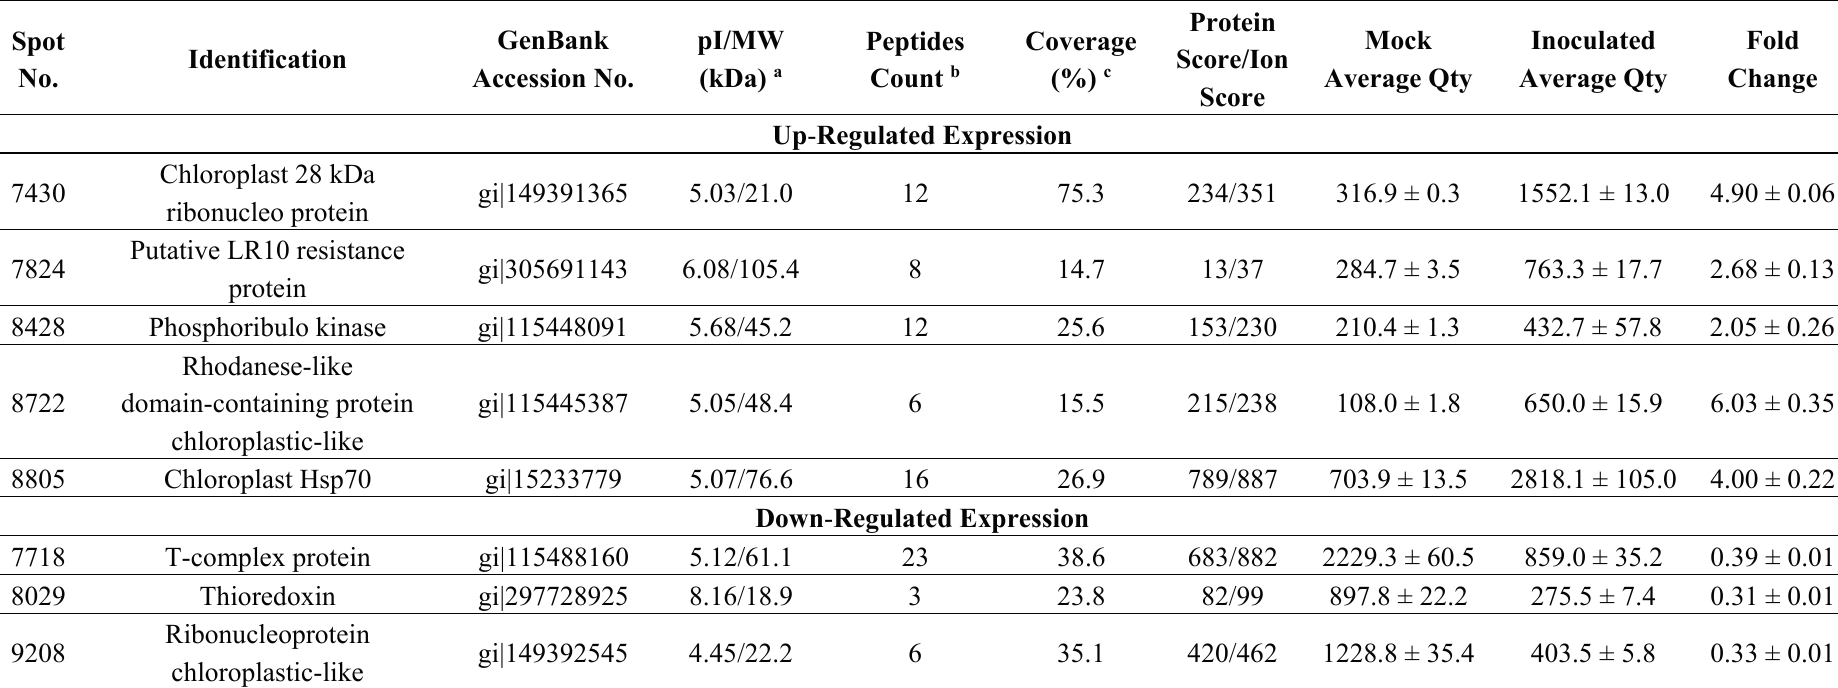
a: pI of predicted protein/molecular mass of predicted protein (kDa); b: Number of peptides for protein identification; c: Percentage of protein sequence represented by peptides identified in